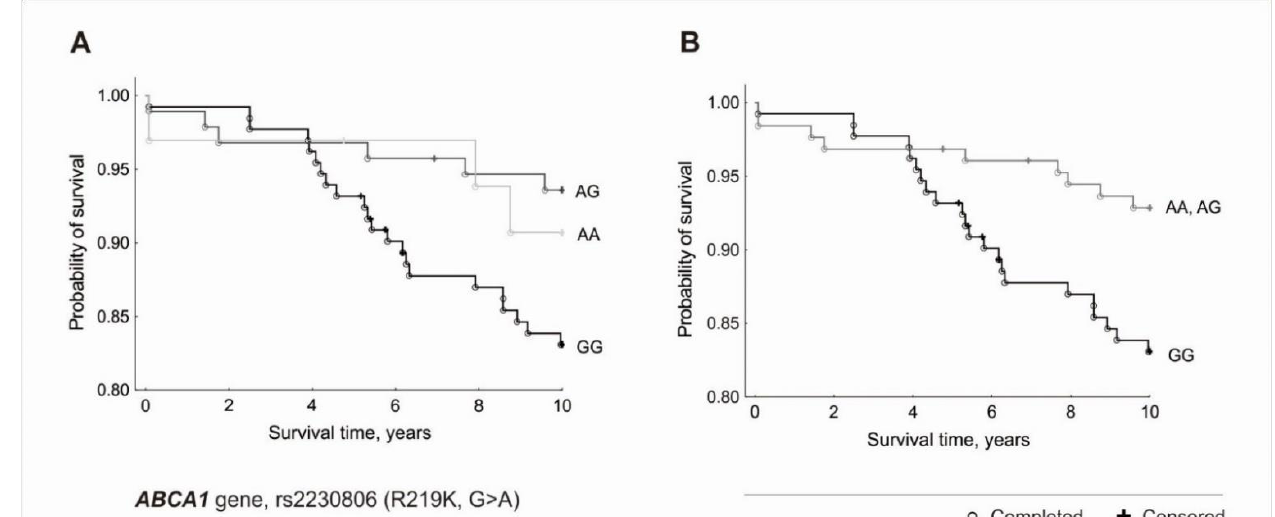
Figure 2. Kaplan-Meier survival curves for CAD patients by ABCA1 gene (rs2230806 R219K, G > A): ( A ) 10-year survival in additive model ( p = 0.04 in the Cox proportional hazard model, p = 0.06 in the χ2 test) ( B ) 10-year survival in a dominant model ( p = 0.02 in the Cox proportional hazard model, p = 0.02 in the log-rank test).